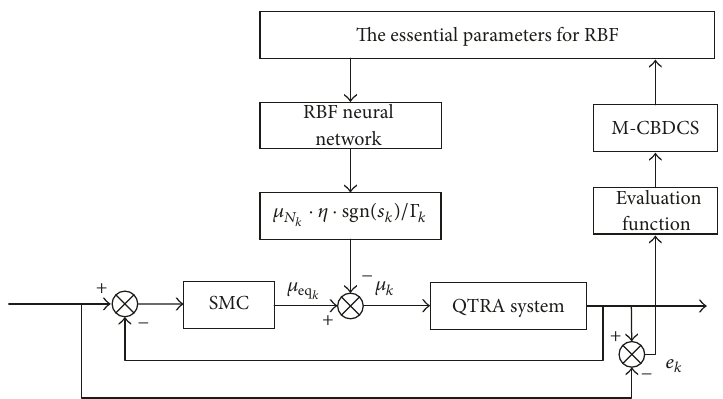
Figure 6: The control structure of the adaptive neural network sliding mode controller for QTRA.